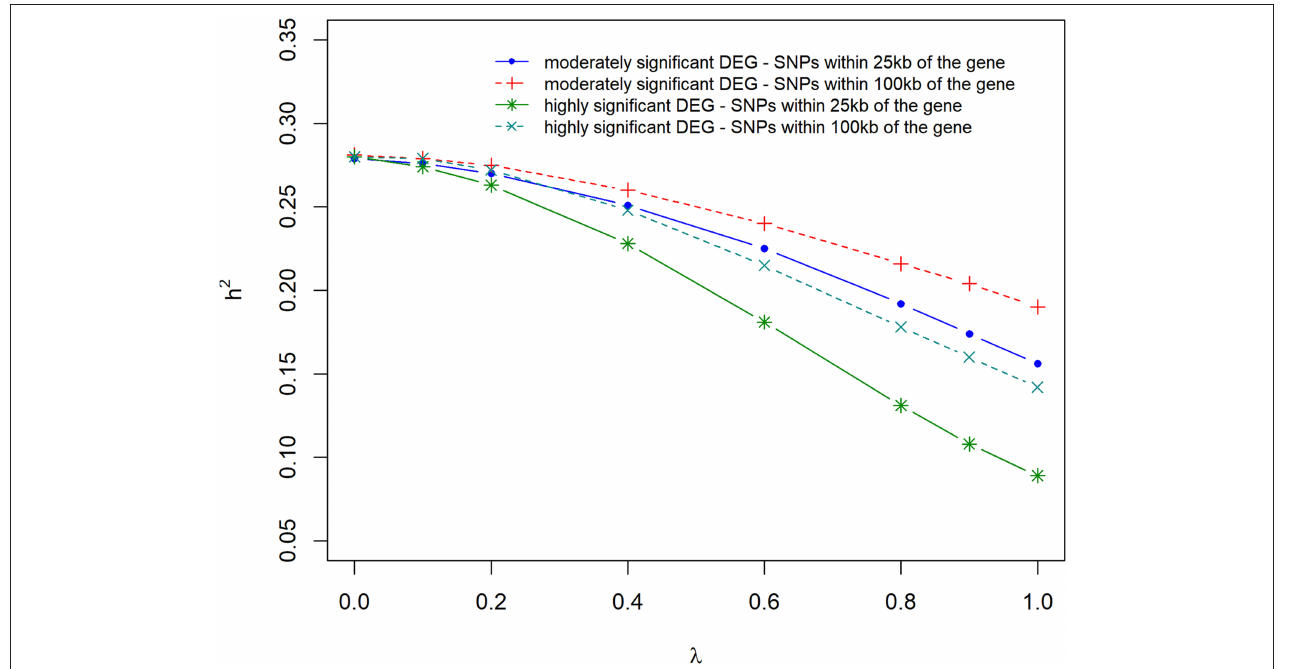
FIGURE 5 | Estimate of heritability for different λ (blending of two genomic relationship matrices) values. The two genomic relationship matrices were generated for SNPs that were either within significant differentially expressed (DE) genes in gene expression analysis or not. Markers within significant DE genes were also weighted with the log2 1 F of that